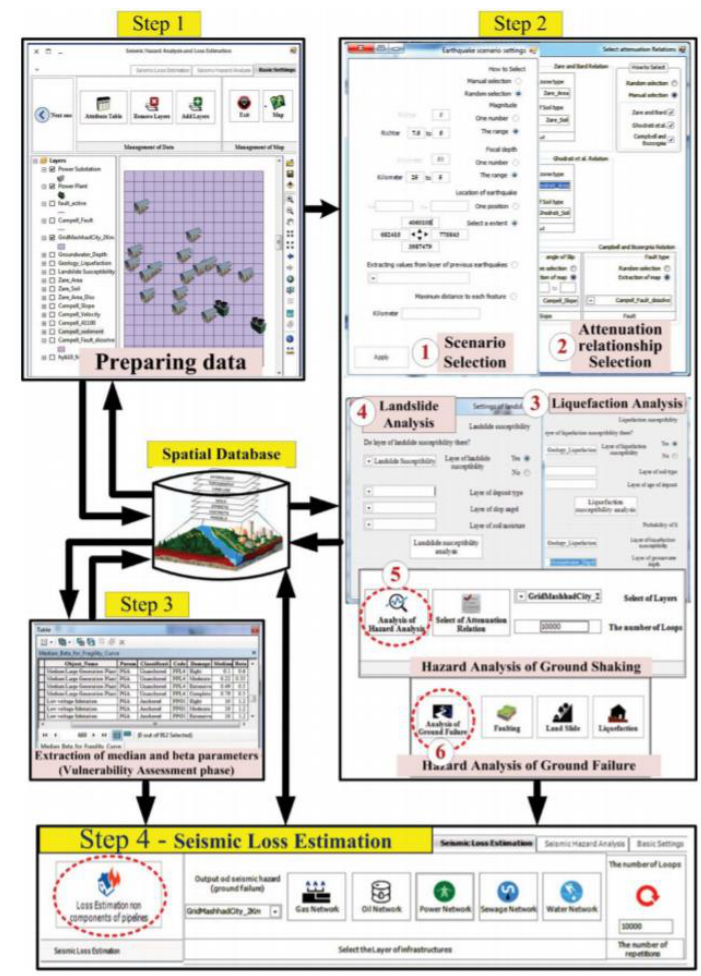
Figure1. Proposed systematic procedure of earthquake damage